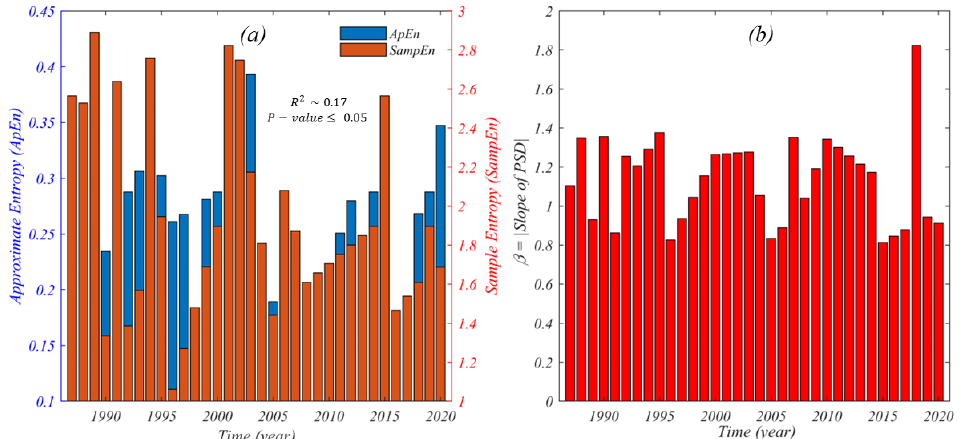
Figure 7. ( a ) Computed Approximate Entropy ( ApEn ) and Sample Entropy ( SampEn ) on AF series in a bar plot and ( b ) the corresponding β calculated by fitting the slope to the estimated PSD of AF series plotted on a log–log